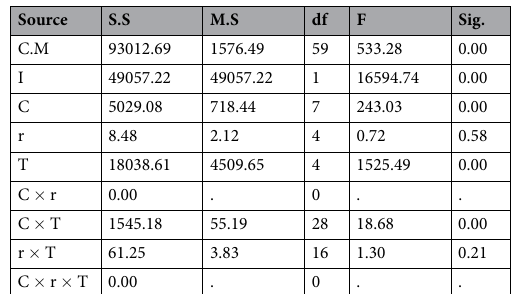
. . Table 2. Analysis of variance of the effect of hatching (%) versus concentration, replication and time. Whereas: S.S (Sum of square); M.S (Mean square); df (Degree of freedom); C.M (Corrected model); I (Intercept); C (Concentration); r (Replication); T (Time); C × r (Concentration × Replication); C × T (Concentration × Time); r × T (replication × Time); C × r × T (Concentration × replication × Time).